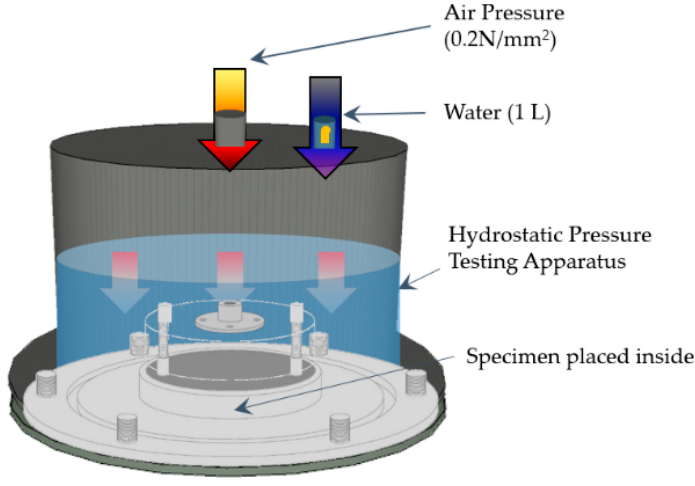
Figure 10. Hydrostatic pressure testing illustration.